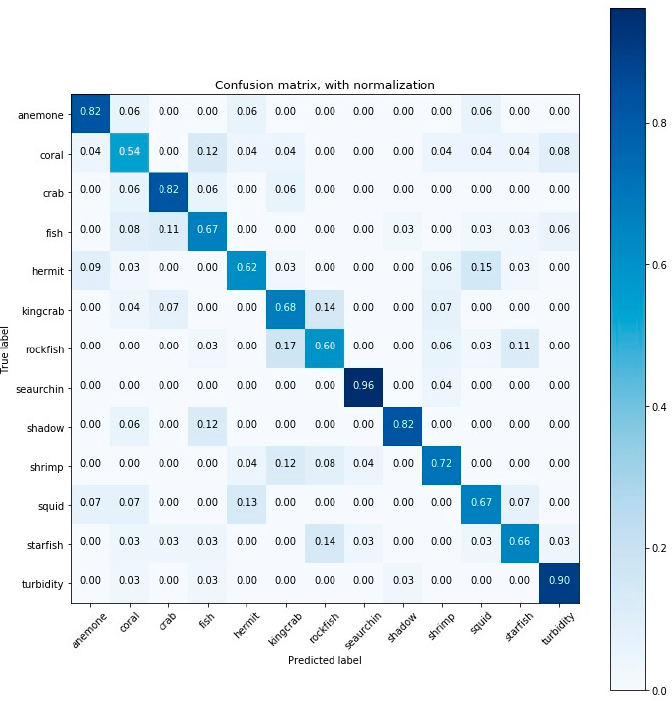
Figure A10. Confusion matrix for the classification results (accuracy) obtained by CNN-3. Sensors 2020 , 20 , 726